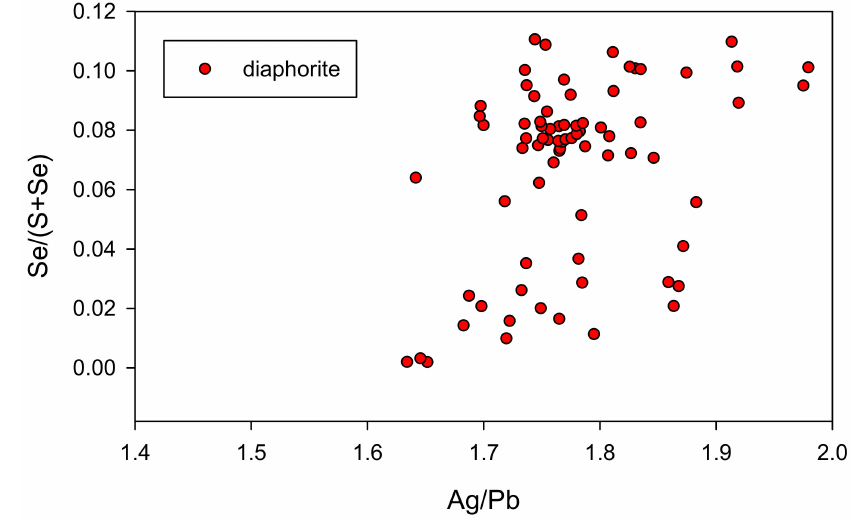
Figure 21. Graph of Ag/Pb vs. Se/(S + Se) ( apfu ) for diaphorite from the Kremnica